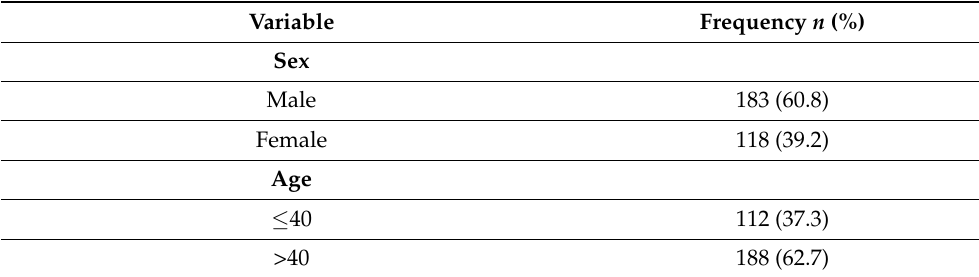
Table 1. Socio demographic characteristics of eye healthcare workers in Uganda ( n =